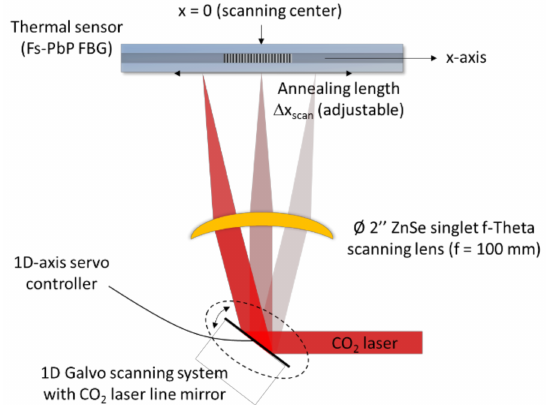
Figure 8. Scheme of CO 2 laser-based annealing setup to regenerate a FBG.